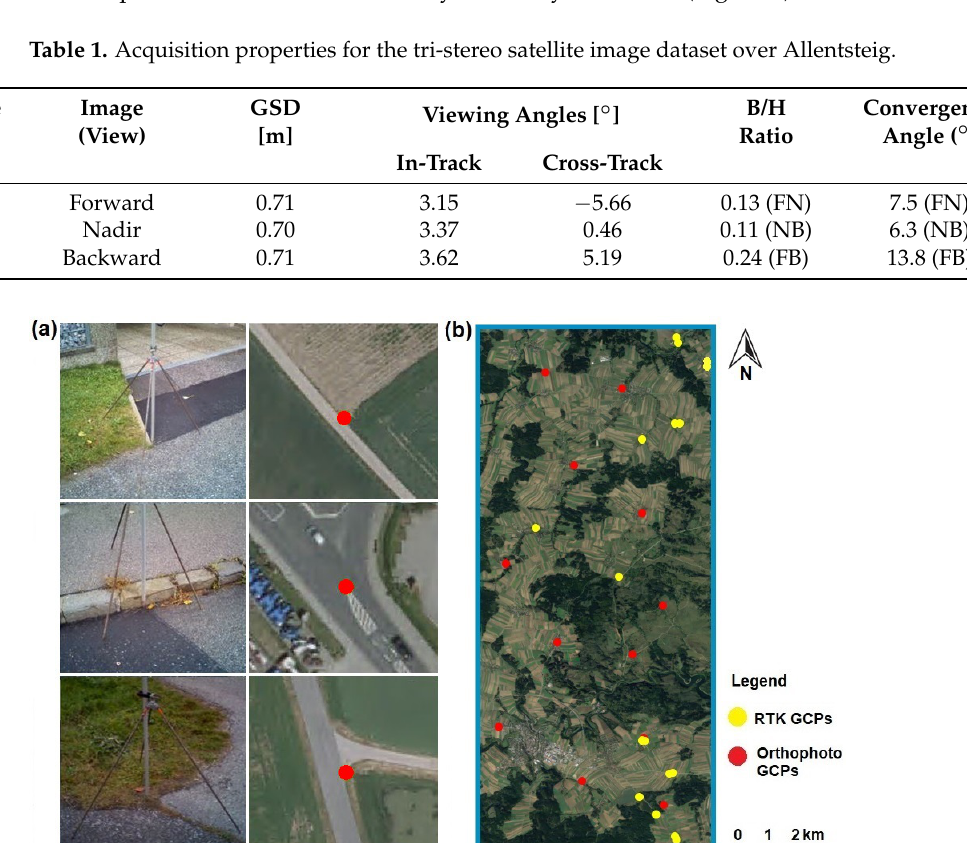
Figure 3. Measurement of GCPs: ( a ) GCPs measured by means of RTK GNSS (left column) and manually measured in orthophoto (right column). ( b ) Overview of GCPs’ distribution in Google